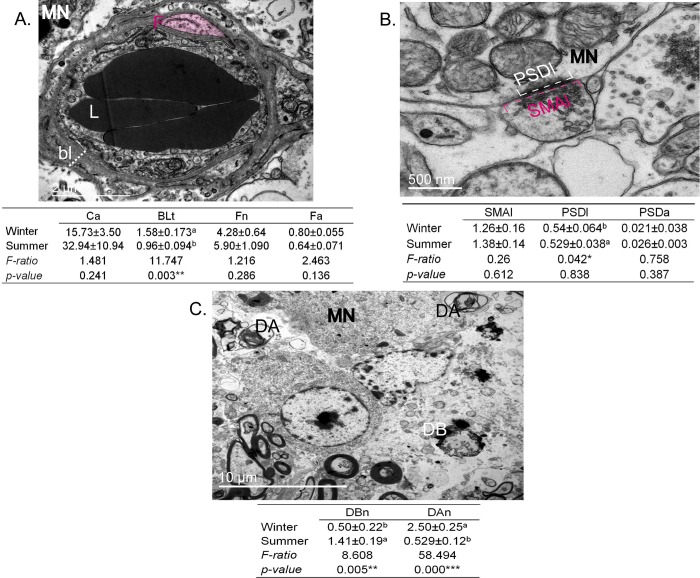
Quantitative analysis of dromedary SON parameters comparing winter and summer.(A) Statistical analysis of capillary parameters (18 capillaries from 3 slices from 3 animals for each season). Ca: area of lumen; BLt: thickness of basal lamina (dashed line); Fn: number of fenestrations (in pink); Fa area of fenestrations. ** Significant seasonal variations (p < 1%). (B) Statistical analysis of synapse parameters (32 synapses from 3 slices from 3 animal for each season). SMAl: synaptic membrane apposition length (dashed lines in pink); PSDl: post-synaptic density length (dashed lines in white); PSDa: post-synaptic density-area (dense area at the side of magnocellular (MN) cell body membrane). * Significant seasonal variations (p < 5%). (C) Statistical analysis of number and kind of debris: DBn: number of degenerating bodies; DAn: number of degenerating axons. ***High significant seasonal variations (p < 0.01%). DA: degenerating body; DA: degenerating axon. F: fenestration; bl: basal lamina; MN: magnocellular neurone; L: lumen.